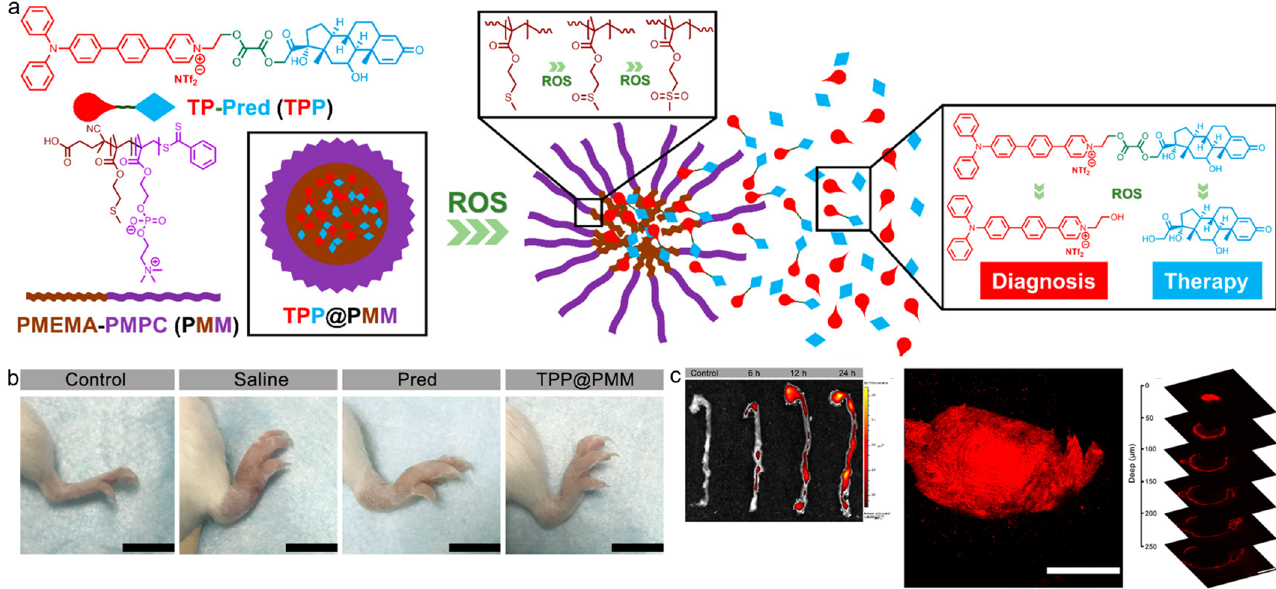
Figure 4. ( a ) Schematic of the theranostic nanoplatform with serial ROS response; ( b ) photographs of the hind limbs from arthritic mice with different treatments; ( c ) two-photon fluorescence imaging of aortas, atherosclerotic plaques, and plaques. Scale bars: 200 µm. (Reproduced with the permission from Ref. [114]. Copyright 2020, American Chemical